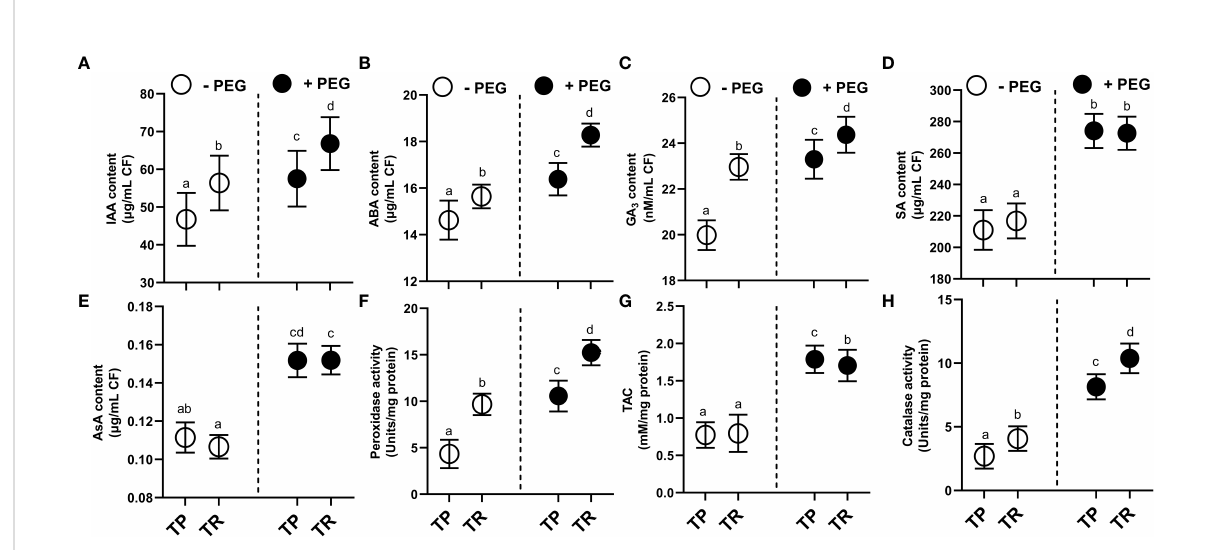
FIGURE 3 Hormonal contents and enzymatic and non-enzymatic antioxidants in CF of TP and TR isolates. (A) IAA, (B) ABA, (C) GA 3 , and (D) SA content. (E) AsA content, (F) Peroxidase enzyme activity, (G) total antioxidant capacity, and (H) Catalase enzyme activity. Quantitative data is representing the means ± SE values of at least three independent biological replications. Various letters have been presented to show the statistical differences at signi fi cance level of p¾ 0.05 using Duncan ’ s Multiple Range Test (DMRT). CF, Culture